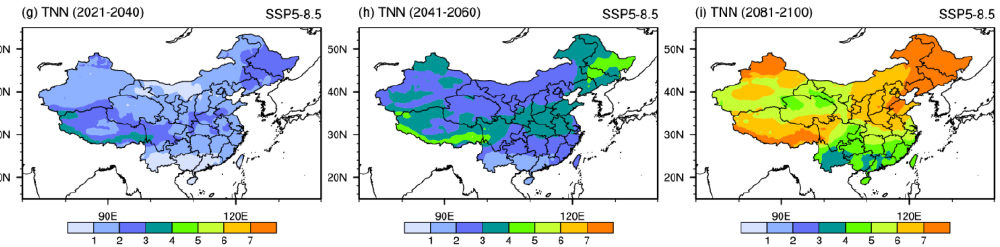
Figure 8. Spatial patterns of extreme temperature indices (TXX, TNN, units: °C; TX90P, units: %)